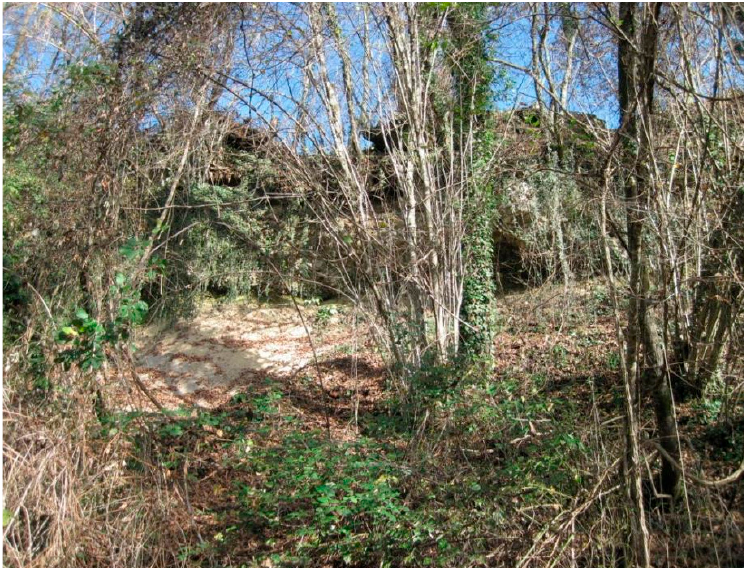
Figure 7. Landslide photograph code 025021_05c, rotational sliding.